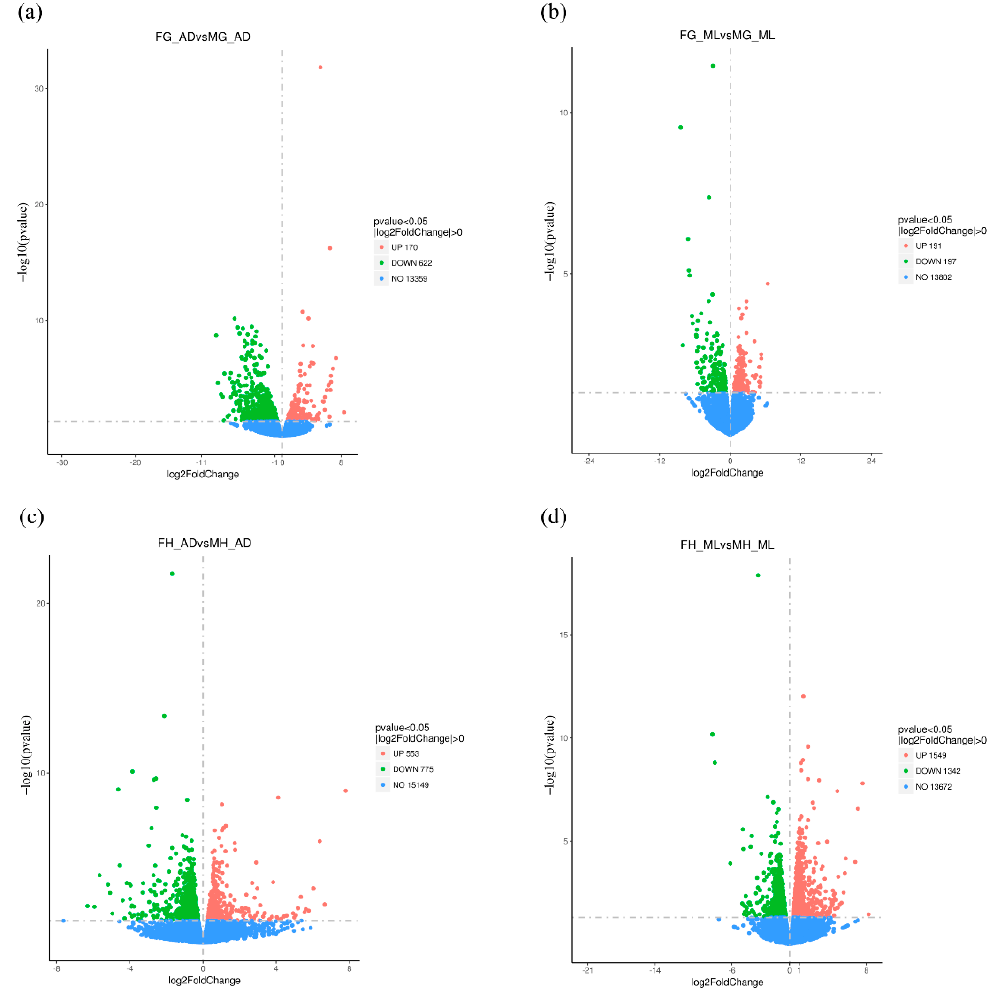
Figure 3. Volcano plot of DEGs between female and male silkworms. Volcano plot for pair wise comparison for ( a ) FG_ADvsMG_AD, ( b ) FG_MLvsMG_ML, ( c ) FH_ADvsMH_AD and ( d ) FH_MLvsMH_ML. Horizontal oridinate represents the fold change of gene expression, and the vertical ordinate represents the statistical significance of the change. Number of DEGs expressions (normalized to Log2 fold change) are displayed on the right side of each picture based on a p -adj cut-off of <0.05. The red plot represents a differentially upregulated gene, a green plot represents a differentially downregulated gene, and the blue plot means a gene that does not show differential expression.